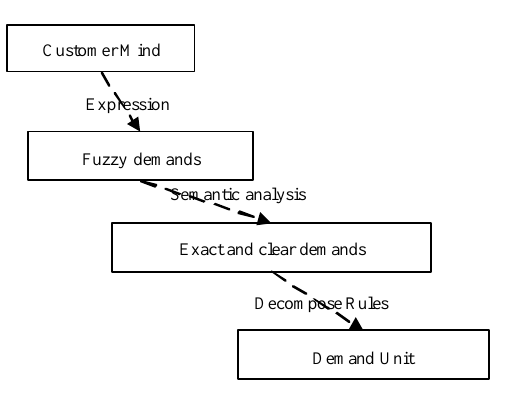
Fig.2. Process of Demand